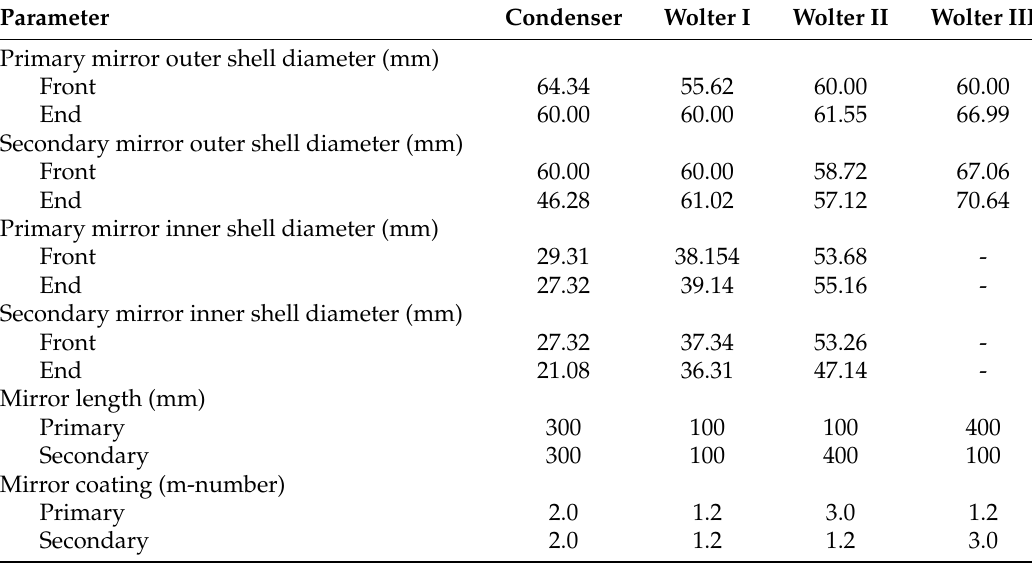
Table A1. Design Parameters for Wolter Type I, II, and III Microscopes with 10 × Magnification. Parameter Condenser Wolter I Wolter II Wolter III Primary mirror outer shell diameter